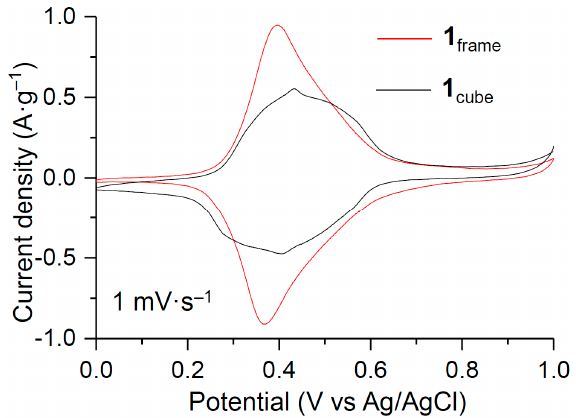
Figure 6. CV curves of 1 crystals at a scanning rate of 1 mV·s -1 .